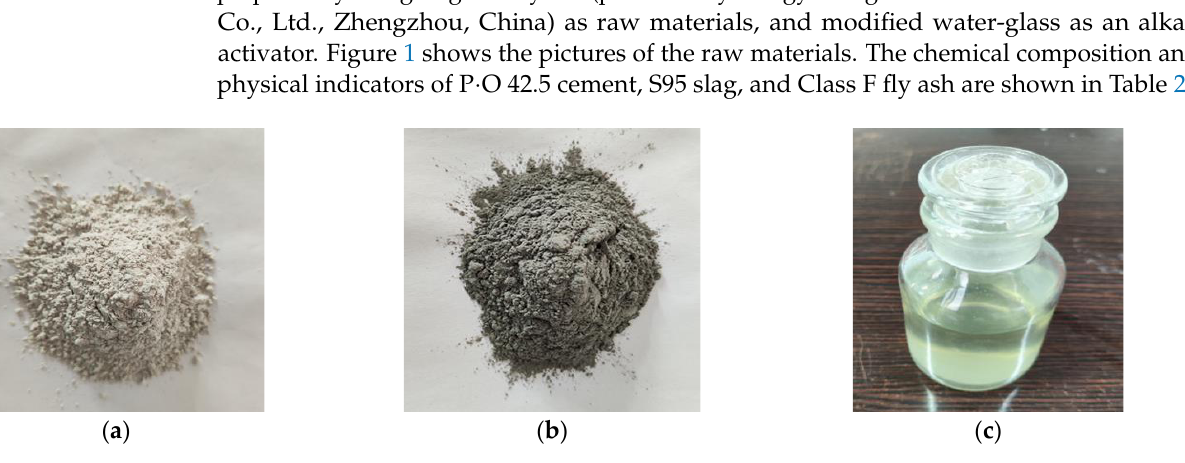
Figure 1. Pictures of raw materials: ( a ) Slag; ( b ) Fly ash; ( c ) Modified water-glass. Table 2. Chemical composition and physical indicators of raw materials (wt%).